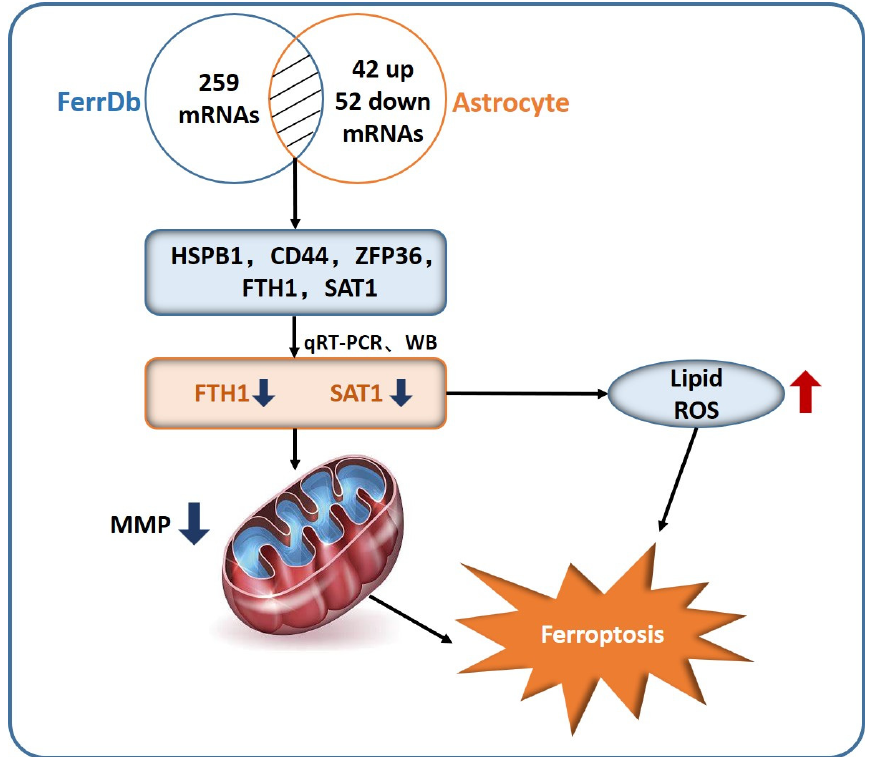
Figure 9. Schematic diagram showing astrocyte ferroptosis in AD. Decreased FTH1 and SAT1 resulted in a decrease in mitochondrial membrane potential and accumulation of lipid ROS and eventually led to astrocyte ferroptosis in AD. MMP: mitochondrial membrane potential.